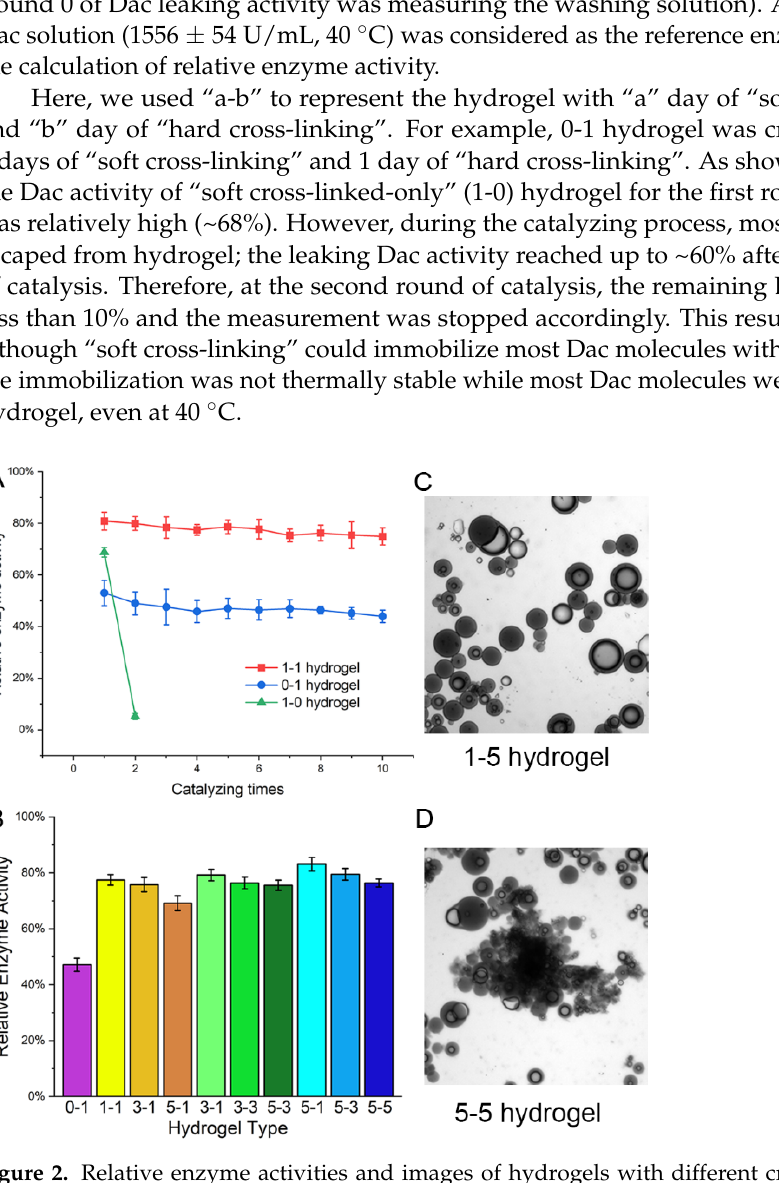
Figure 1. Fabrication of two-step cross-linked hydrogel for Dac immobilization. ( A ) Procedure of two-step cross-linked hydrogel. ( B ) Scanning electron microscope (SEM) image of hydrogel parti- cles with a magnification scale of 1200×.